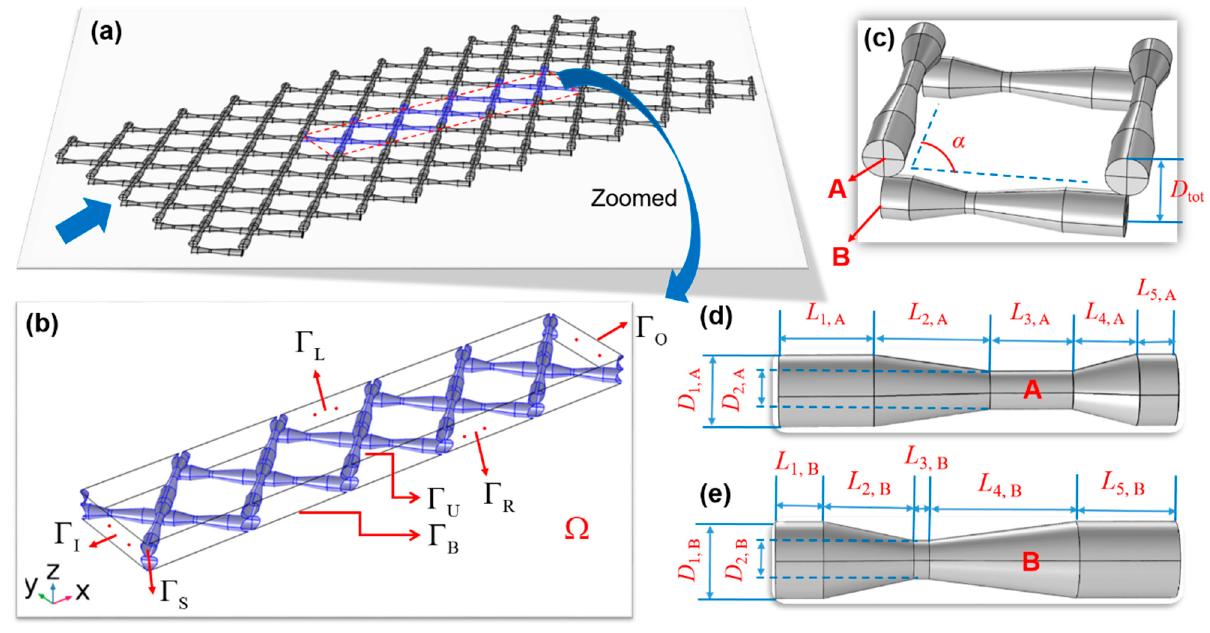
Figure 2. ( a ) Spacer sheet; ( b ) The computational domain (spacer-filled channel); ( c ) A spacer unit; ( d ) Filament A; and ( e ) Filament B. ( d ) Filament A; and ( e ) Filament